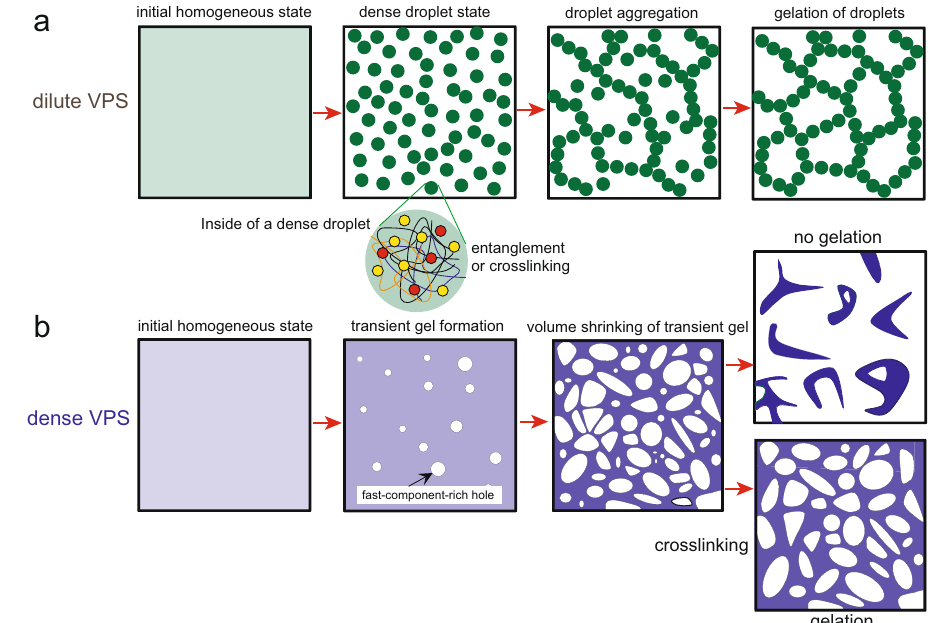
Fig. 2 Schematic representations of two typical types of viscoelastic phase separation (VPS). a VPS in region II of the phase diagram of Fig. 1a. Dense droplets composed of the slow component (polymer) are formed in the fast-component (solvent)-rich phase immediately after phase separation and behave like a gel ball due to the entanglement or crosslinking of polymeric components. We show an enlarged picture of a droplet as an example of biological phase separation, where yellow and red spheres represent binding proteins that crosslink polymers. Then, these droplets aggregate to form a percolated droplet network, i.e. a gel network. This type of VPS is observed when the slow-component-rich phase occupies a much smaller volume fraction than the fast-component-rich phase. b VPS in region IV of the phase diagram of Fig. 1a. A transient gel state is formed immediately after phase separation. Then, the transient gel shrinks while expelling the fast component (solvent) and forms a sponge-like structure. Its further volume shrinking transforms the structure from sponge-like to network-like. In the fi nal phase separation stage, the domain deformation rate slows down drastically. Thus, the slower phase eventually behaves as a fl uid, leading to the morphological transformation from network-like to droplet-like (no gelation). However, if the slower phase is dynamically arrested by crosslinking of polymeric components or vitri fi cation, the sponge-like or network-like structure is frozen as a gel and stabilised (gelation). The darker domain colour in panels a and b represents higher polymer deep quench, especially if energetic entanglements due to Fig. 3g – i) and porous network structures of centrosome assembly much attractive interactions between chains, which makes τ (see Fig. 4c, d in ref. 21 ). As explained above, the force-balance t condition (Eq. (1)) leads to the network morphology of the slow- longer, are taken into account. Due to this mechanism of droplet component-rich phase, where three and four arms are connected at coalescence, the droplet size R grows much slower than the a junction in 2D and 3D, respectively, to satisfy the force-balance ordinary droplet coarsening law of R (cid:3) t 1 = 3 for simple liquid condition (see Fig. 3 for 2D). binary mixtures 24 .